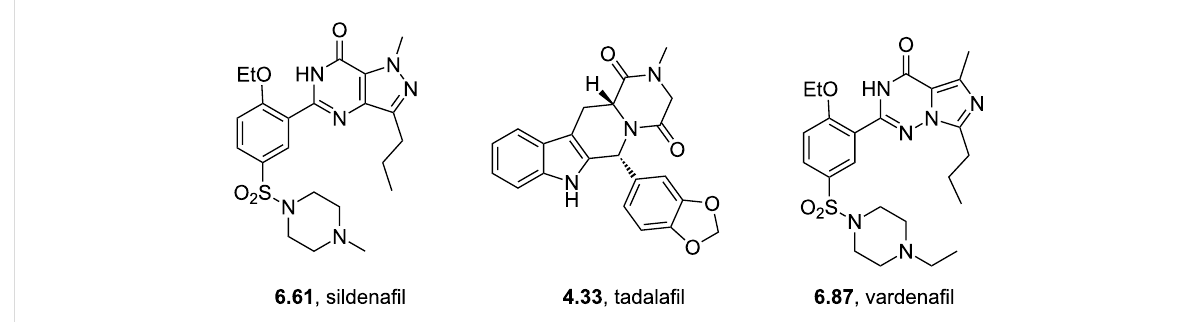
Figure 20: Comparison of the structures of sildenafil, tadalafil and vardenafil.